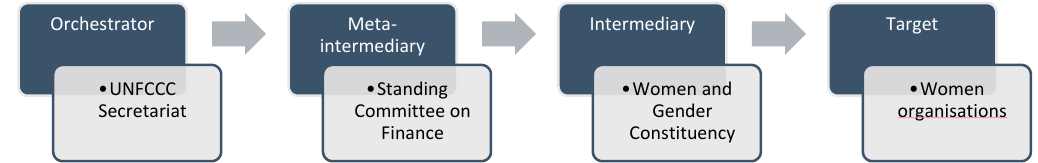
Figure 1. Orchestrating the engagement of women organisations in the UNFCCC led climate finance decision making (developed by the